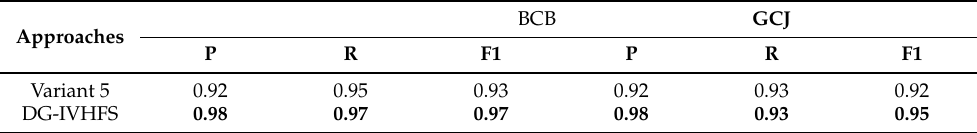
Table 5. The ablation experiment results on BCB and GCJ of